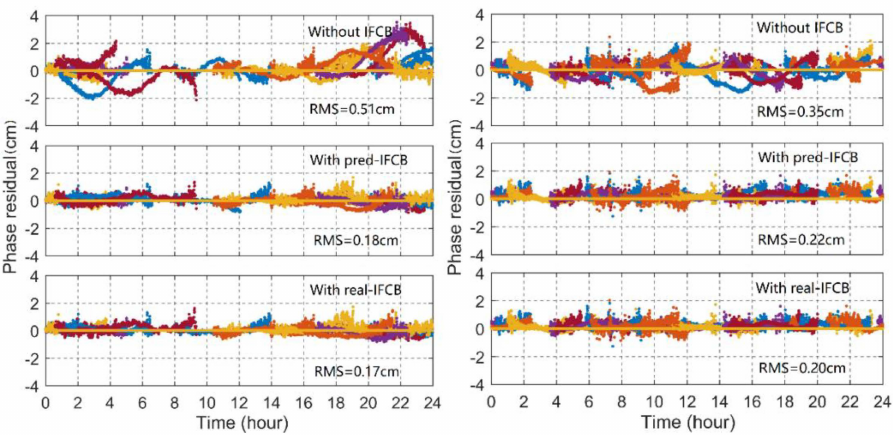
Figure 9. Phase observation residuals for triple-frequency uncombined PPP at the DJIG (left panel) and YEL2 (right panel)